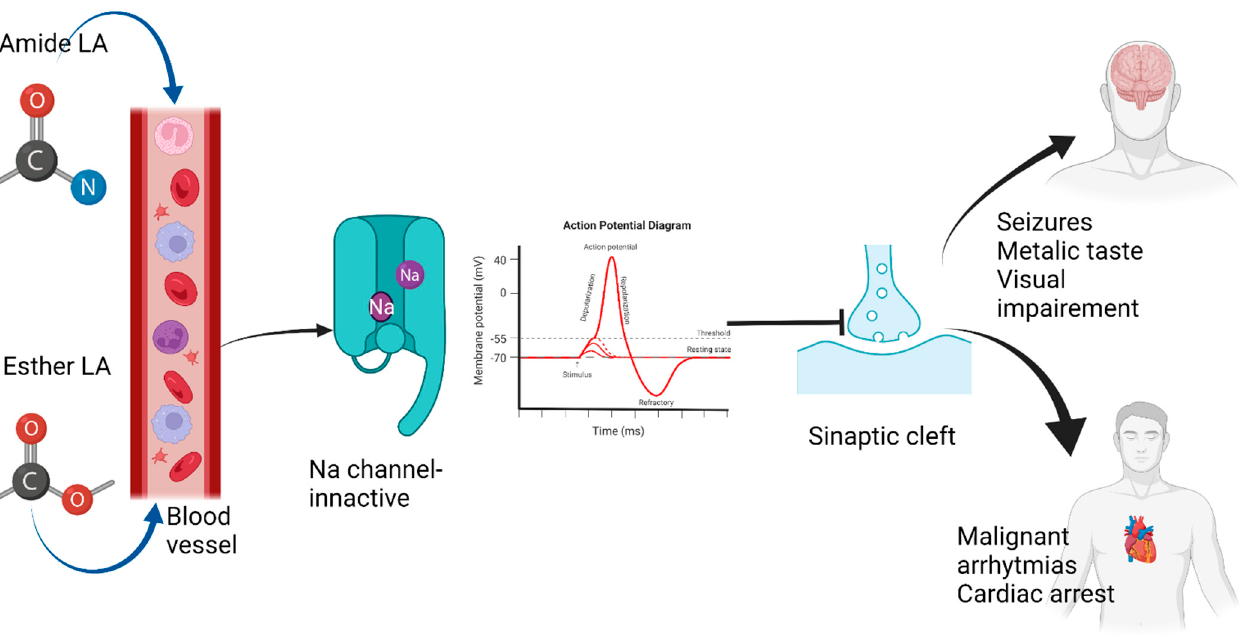
Figure 1. Local anesthetic systemic toxicity mechanism and effects upon the brain and heart.